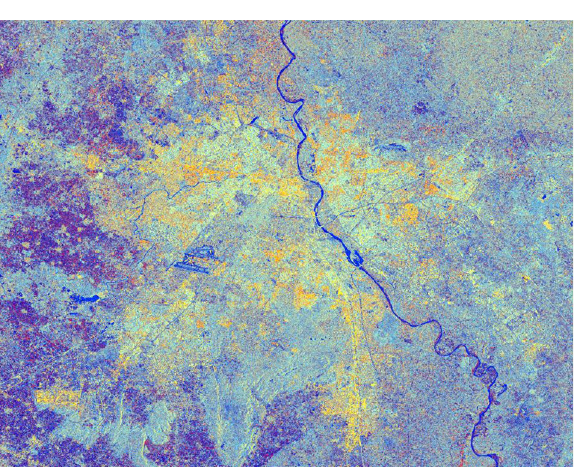
Figure 20. Colour composite image (Red: VV, Green: VH, Blue: VH/VV) of the Sentinel-1 dual-polarization C-band data in with a window size of 17 and sigma value